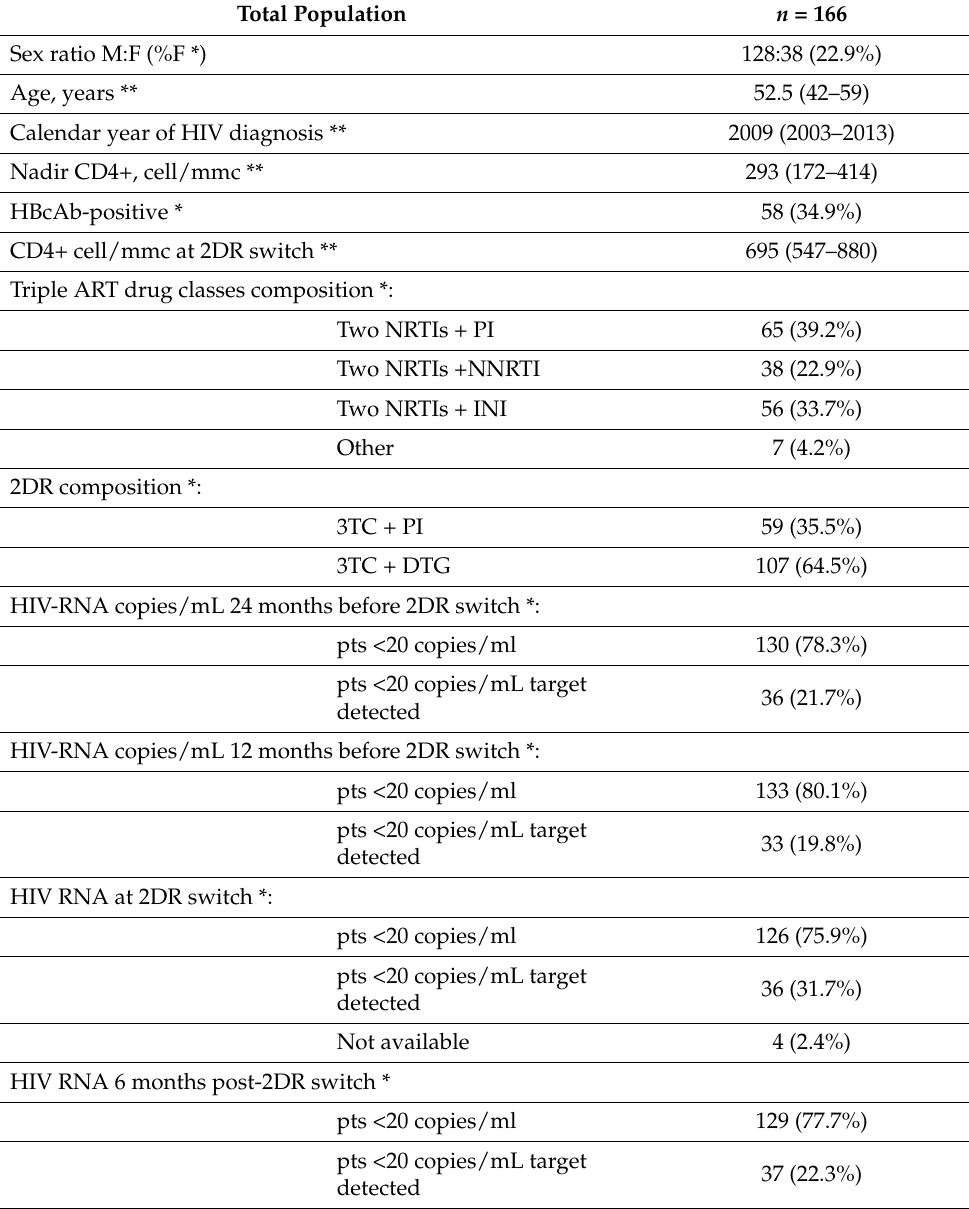
Table 1. Characteristics of the study